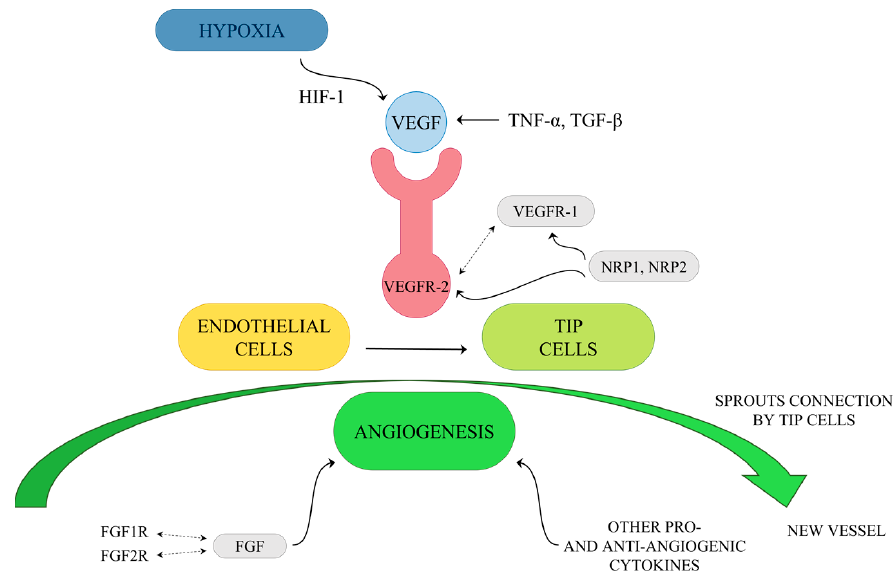
Figure 3. Simplified diagram of tip cells activation by VEGF.